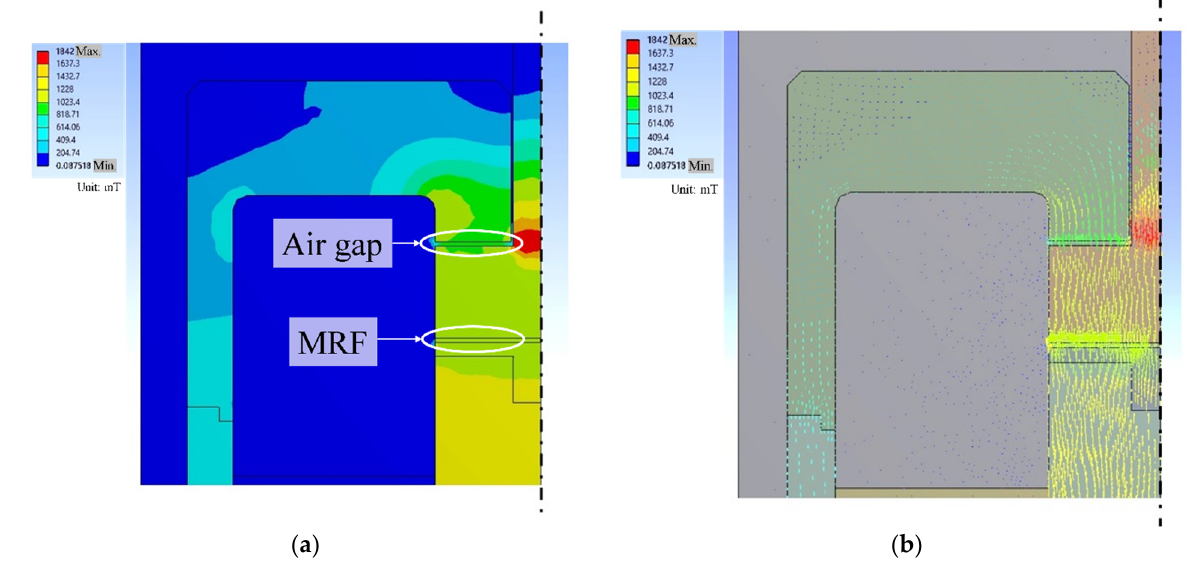
Figure 8. Distribution of magnetic field in the parallel plate setting (fluid gap). ( a ) Contour, ( b ) vector.